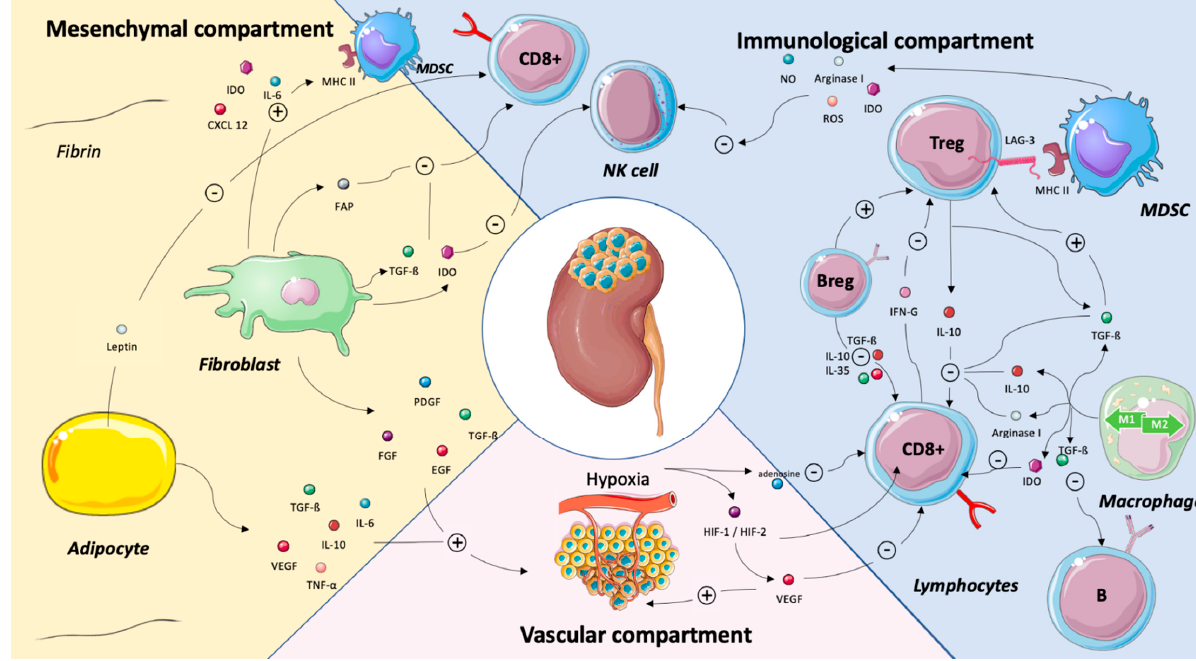
Figure 2. Major cross-talks between the mesenchymal, the immune and the vascular compartments in renal cell carcinoma. Abbreviations: B-reg: B regulatory cells, CD8: cluster of differentiation 8, CXCL2: chemokine (C-X-C motif), EGF: epidermal growth factor, FAP: fibroblast activation protein, FGF: fibroblast growth factor, HIF-1/HIF-2: hypoxia-induced factor-1/hypoxia)-induced factor 2, IDO: indoleamine 2,3-dioxygenase, IFN- γ : interferon γ , IL: interleukin, LAG3: lymphocyte-activation gene 3, MHC: